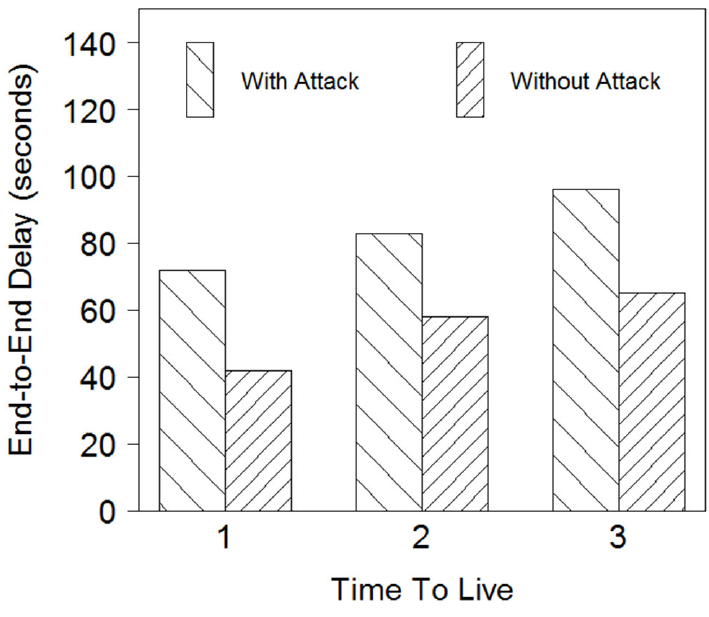
Figure 9. End ‐ to ‐ end delay vs. time to live.